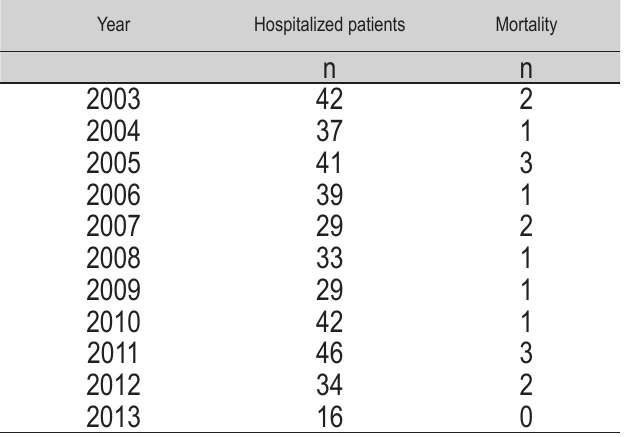
Table 2 - The frequency of hospitalization and mortality of patients from 2003 to 2013 in HMOB’s Dental